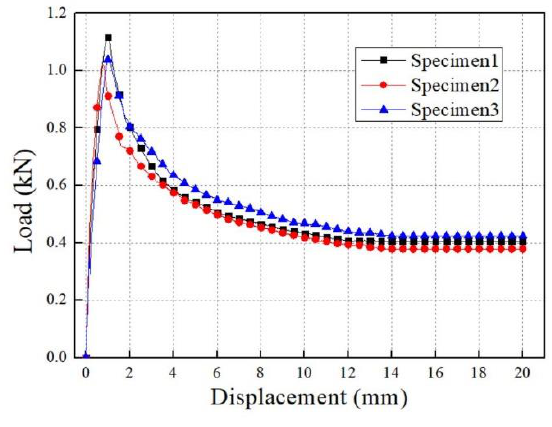
Figure 4. The load–displacement curves. Figure 4. The load – displacement curves. Figure 4. The load – displacement curves. Table 2. Maximum load and stable load for each Table 2. Maximum load and stable load for each specimen. Table 2. Maximum load and stable load for each specimen.